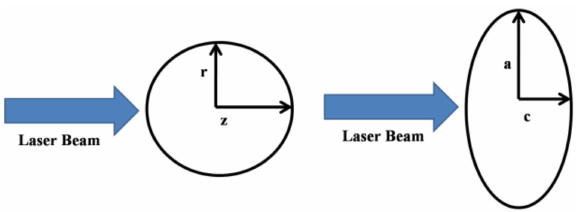
Figure 1. Geometry of the computational method: a sphere versus a rotation